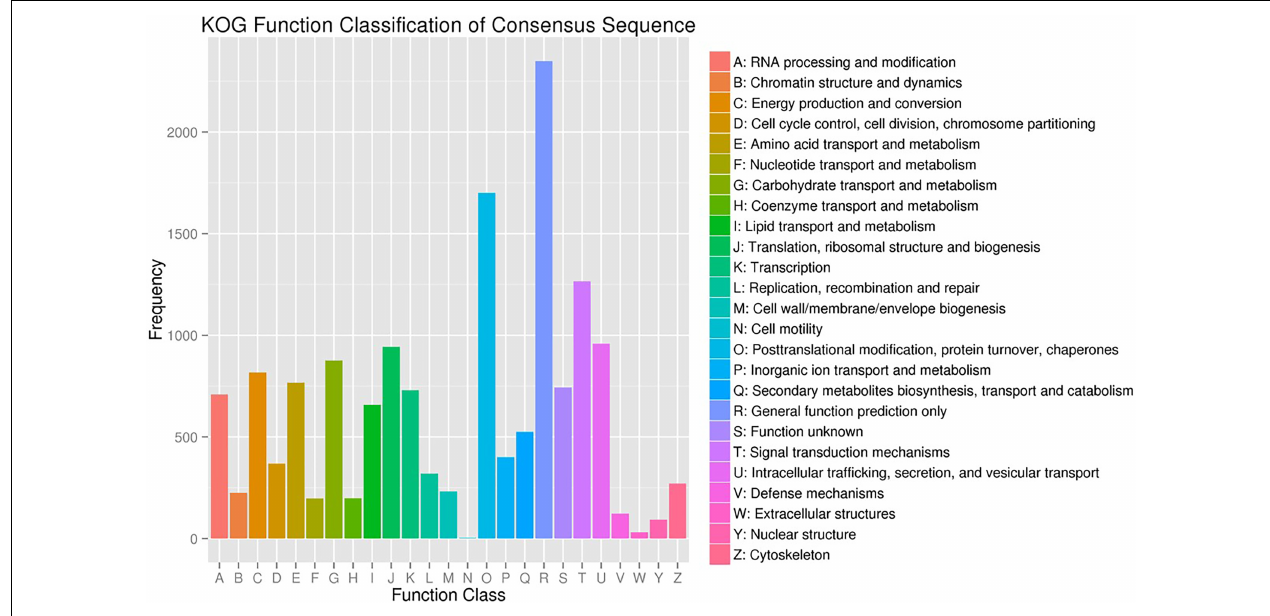
FIGURE 2 | EuKaryotic Ortholog Groups (KOG) classification of assembled unigenes.